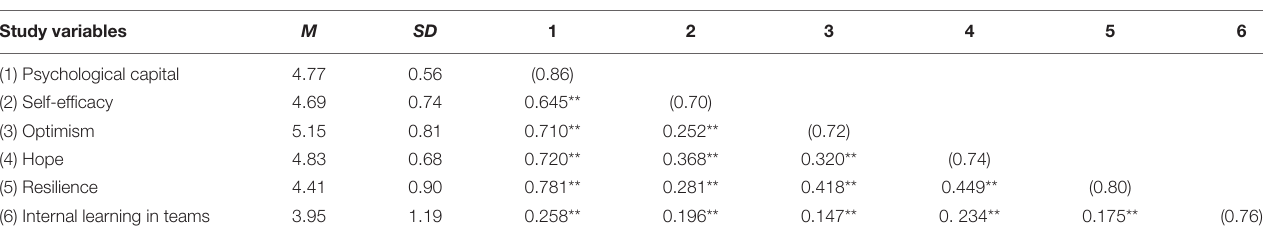
TABLE 1 | Means, standard deviations, and correlations between study variables. Study